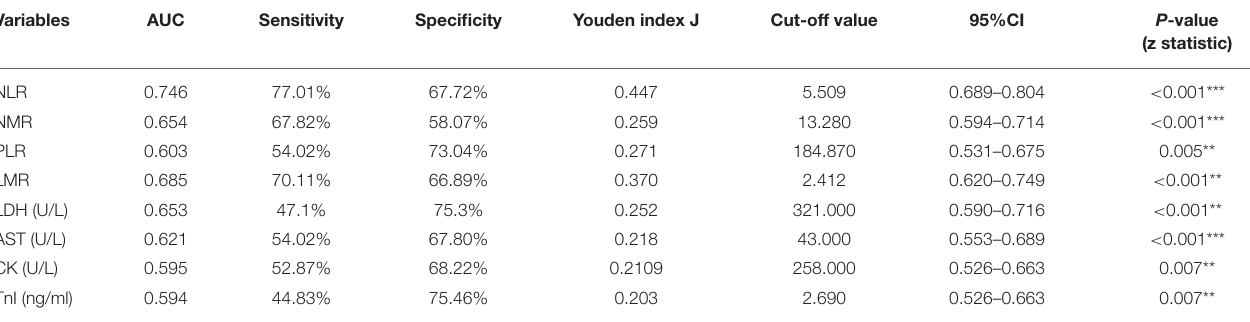
TABLE 3 | The ROC curve and cut-off values of common ratios and markers of myocardial injury predicting in-hospital death in NSTEMI group. Variables AUC Sensitivity Specificity Youden index J Cut-off value 95%CI P -value